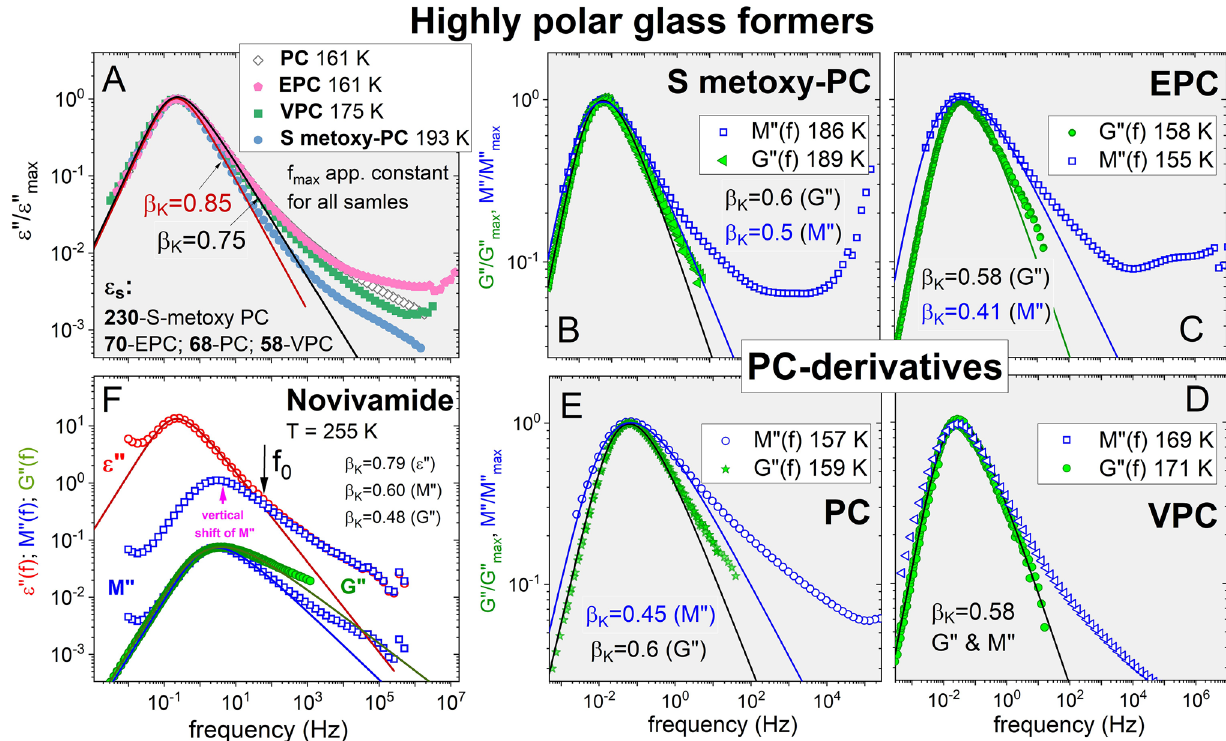
Figure 6. ( A ) Shows the narrow dielectric α-loss peaks of propylene carbonate (PC) and the PC derivatives, S metoxy-PC, EPC, and VPC. The Kohlrausch fits have β DS K falling within the range from 0.75 to 0.85 and correlate with Δε. ( B ) Shows the normalized M ″ ( f ) at 186 K, and the normalized G ″ ( f ) at 189 K of S metoxy-PC, and the Kohlrausch fits with β M K = 0.50 and β G K = 0.60. ( C ) Shows the normalized M ″ ( f ) at 155 K, and the normalized G ″ ( f ) at 158 K of EPC, and the Kohlrausch fits with β M K = 0.41 and β G K = 0.58. ( D ) Shows the normalized M ″ ( f ) at 169 K, and the normalized G ″ ( f ) at 171 K of VPC, and the Kohlrausch fits with β M K = 0.58 and β G K = 0.58. ( E ) Shows the normalized M ″ ( f ) at 186 K, and the normalized G ″ ( f ) at 189 K of PC, and the Kohlrausch fits with β M K = 0.45 and β G K = 0.60. ( F ) Shows data of ε ″ ( f ) and M ″ ( f ), and the vertically shifted M ″ ( f ) data of the pharmaceutical novivamide at T = 255 K, and the Kohlrausch fits with β DS K = 0.79, β M K = 0.60 and β G K =